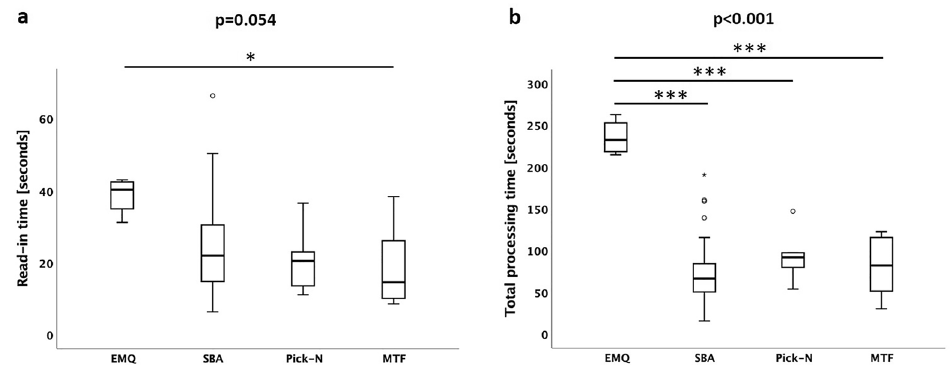
Figure 3. Read-in time and ( a ) total processing time ( b ) for each item type. Parameters are depicted for each item format separately as box plots. *p < 0.05; ***p <